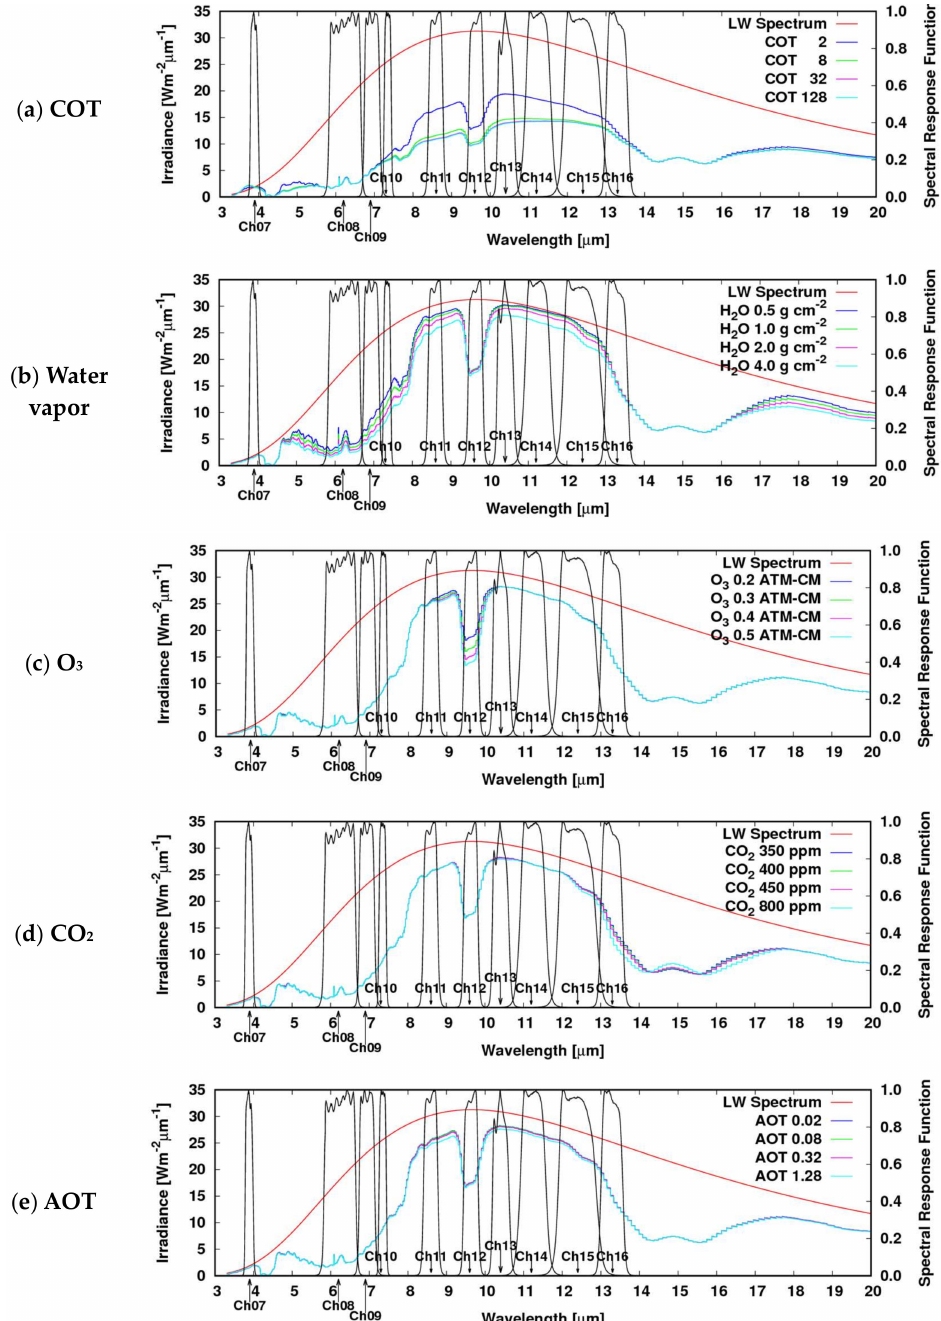
Figure 3. Changes in OLR for different wavelengths based on ( a ) COT (blue: 2, green: 8, magenta: 32, and cyan: 128), concentration of the following absorption gases in the atmosphere ( b ) water vapor (blue: 0.5 g · cm − 2 , green: 1.0 g · cm − 2 , magenta: 2.0 g · cm − 2 , and cyan: 4.0 g · cm − 2 ), ( c ) O 3 (blue: 0.2 ATM-CM, green: 0.3 ATM-CM, magenta: 0.4 ATM-CM, and cyan: 0.5 ATM-CM), and ( d ) CO 2 (blue: 350 ppm, green: 400 ppm, magenta: 450 ppm, and cyan: 800 ppm), and ( e ) AOT (blue: 0.02, green: 0.08, magenta: 0.32, and cyan: 1.28). The red line is the longwave radiation spectrum and the black line is the spectral response function for each channel of the Himawari-8